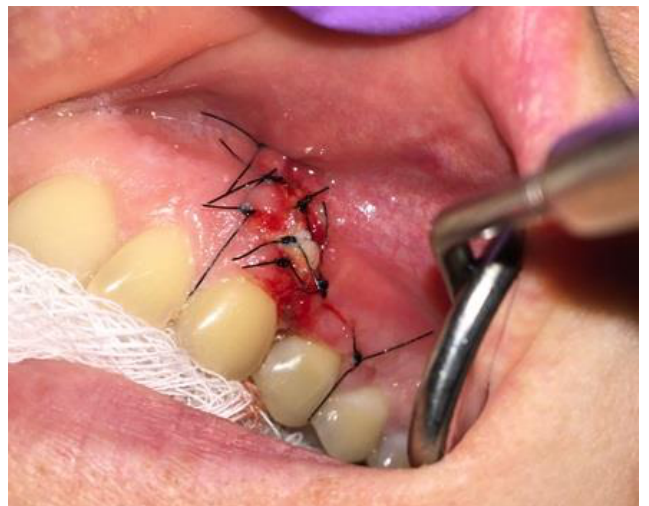
Figure 8. Intraoral photograph 3 days after surgery.